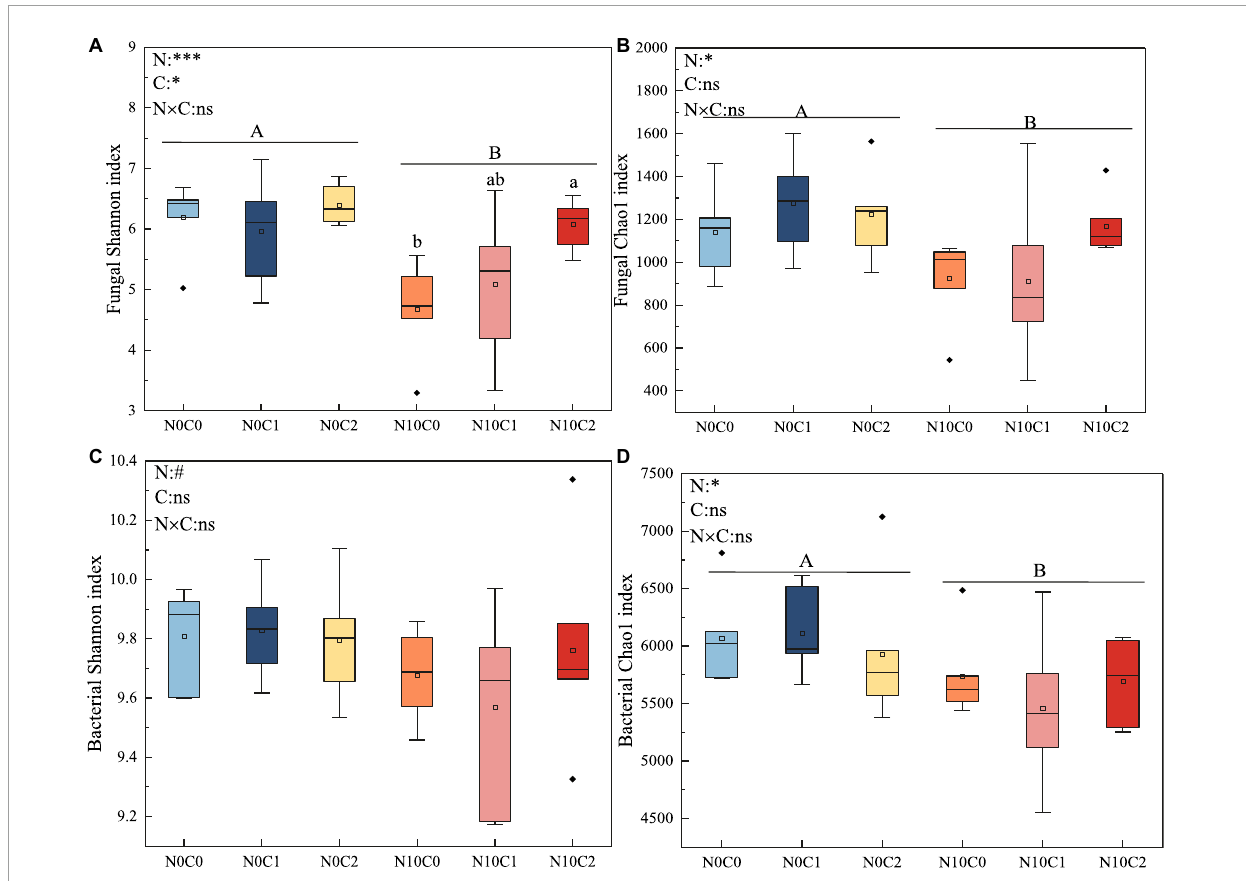
FIGURE1 The 6-year of soil fungal and bacterial Shannon diversity index and chao1 richness in N addition and litter manipulation treatments during 2014–2019. Significance levels were presented to show the effect of N addition (N) and altered litter input (C) treatments and their interaction (N × C) on these parameters ( ns p > 0.1; # p < 0.1; * p < 0.05; ** p < 0.01; *** p < 0.001). The uppercase letters indicate the significant difference between two nitrogen treatments ( p < 0.05), different lowercase letters indicate significant difference among three altered litter input treatments in the case of same nitrogen ( p < 0.05). (A–D) Represents the α diversity indices of soil fungi and bacteria (Shannon index and Chao1 index),